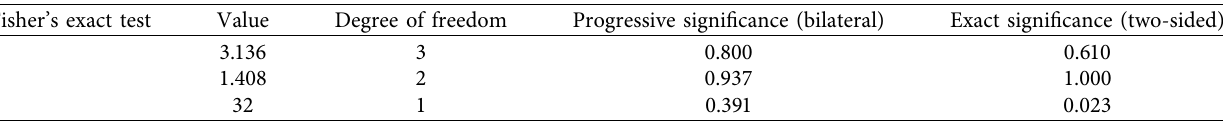
Table 12: Types of fouls and chi-square tests in the competition phase.